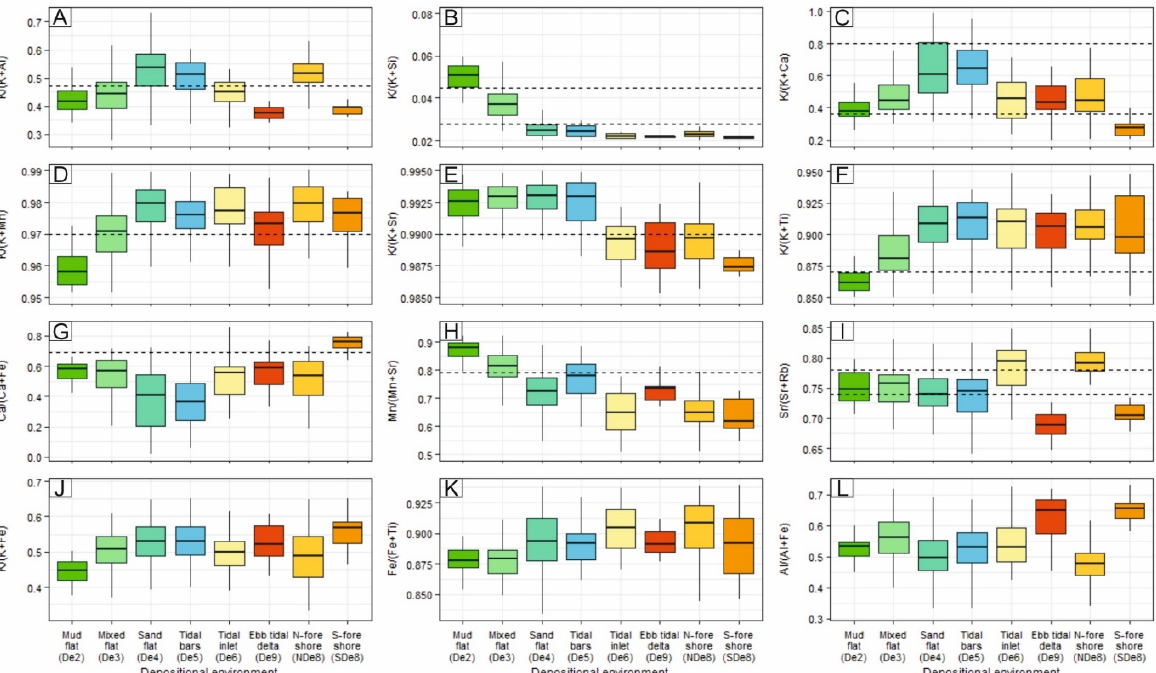
Figure 7. Box plots for element indices as a function of the Ravenglass Estuary depositional environment. ( A ) K/(K+Si), ( B ) K/(K+Ca), ( C ) Mn/(Mn+Sr), ( D ) K/(K+Al), ( E ) K/(K+Mn), ( F ) K/(K+Ti), ment. ( A ) K/(K + Si), ( B ) K/(K + Ca), ( C ) Mn/(Mn + Sr), ( D ) K/(K + Al), ( E ) K/(K + Mn), ( F ) K/(K ( G ) K/(K+Sr), ( H ) Sr/(Sr+Rb), ( I ) Ca/(Ca+Fe), ( J ) Ti/(Ti+Mn), ( K ) Fe/(Fe+Ti), and ( L ) Al/(Al+Fe). + Ti), ( G ) K/(K + Sr), ( H ) Sr/(Sr + Rb), ( I ) Ca/(Ca + Fe), ( J ) Ti/(Ti + Mn), ( K ) Fe/(Fe + Ti), and ( L